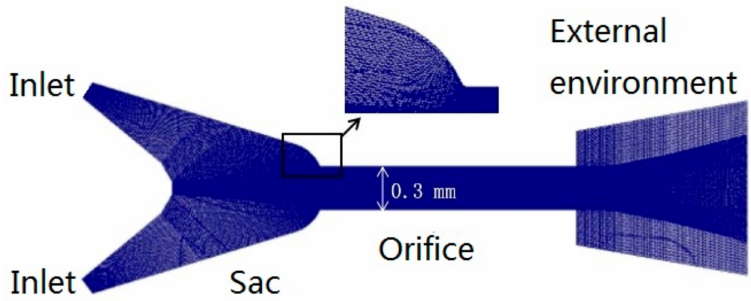
Figure 3. Geometry model of the